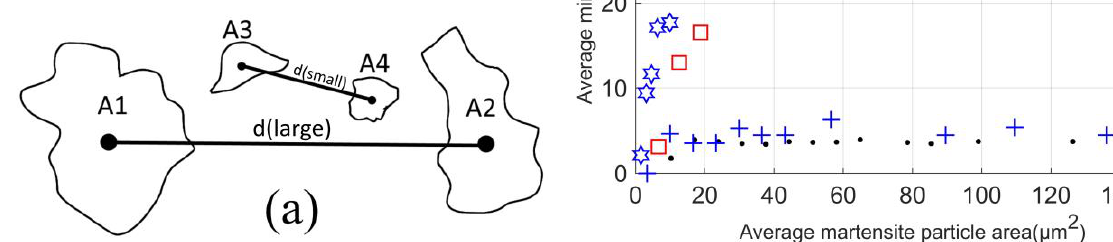
Figure 7 . ( a ) Schematic illustration of the calculation of the minimum distance between particles of certain similar sizes (a) from their centroid, and (b ) the average minimum distance between the α’ - martensite particles of similar size as a function of their average areas at different strain rates. The quasi in-situ tests were carried out to a true strain of 0.2 with increments of 1.3% true strain, and the interrupted tests were carried out to a true strain of 0.18 with larger increments of 5%. Interrupted test data were adopted from [18].